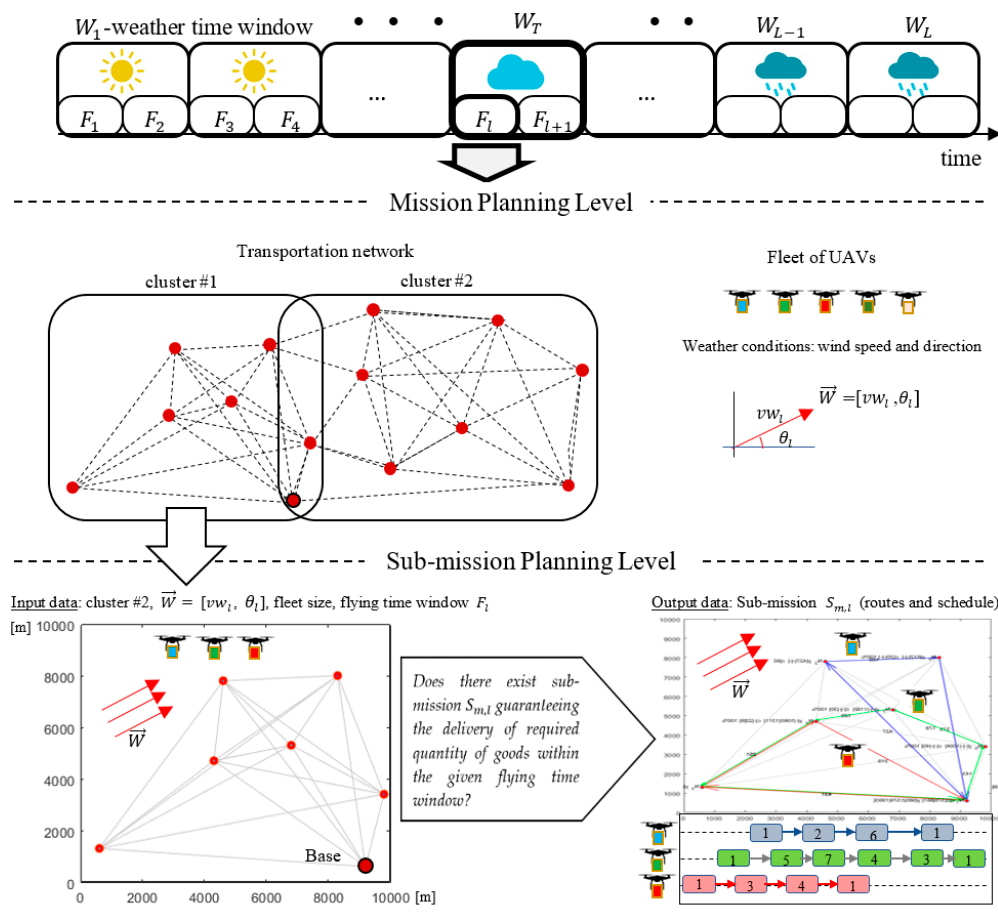
Figure 4. Illustration of mission planning